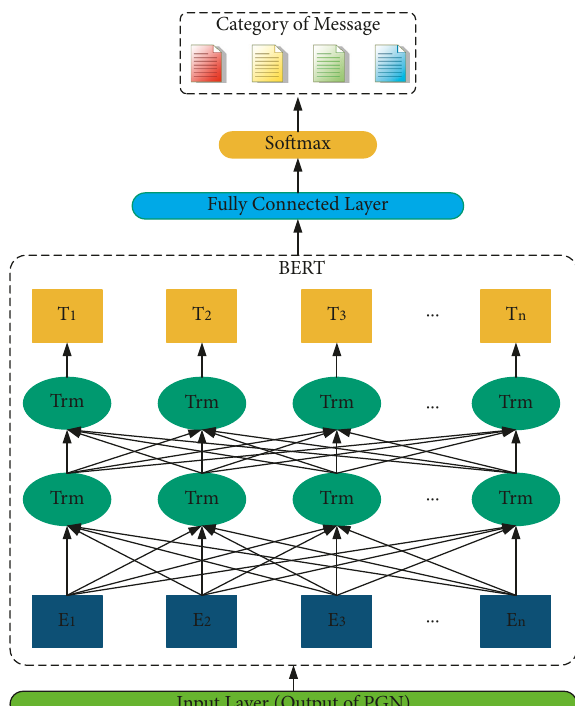
Figure 3: Text classification model based on